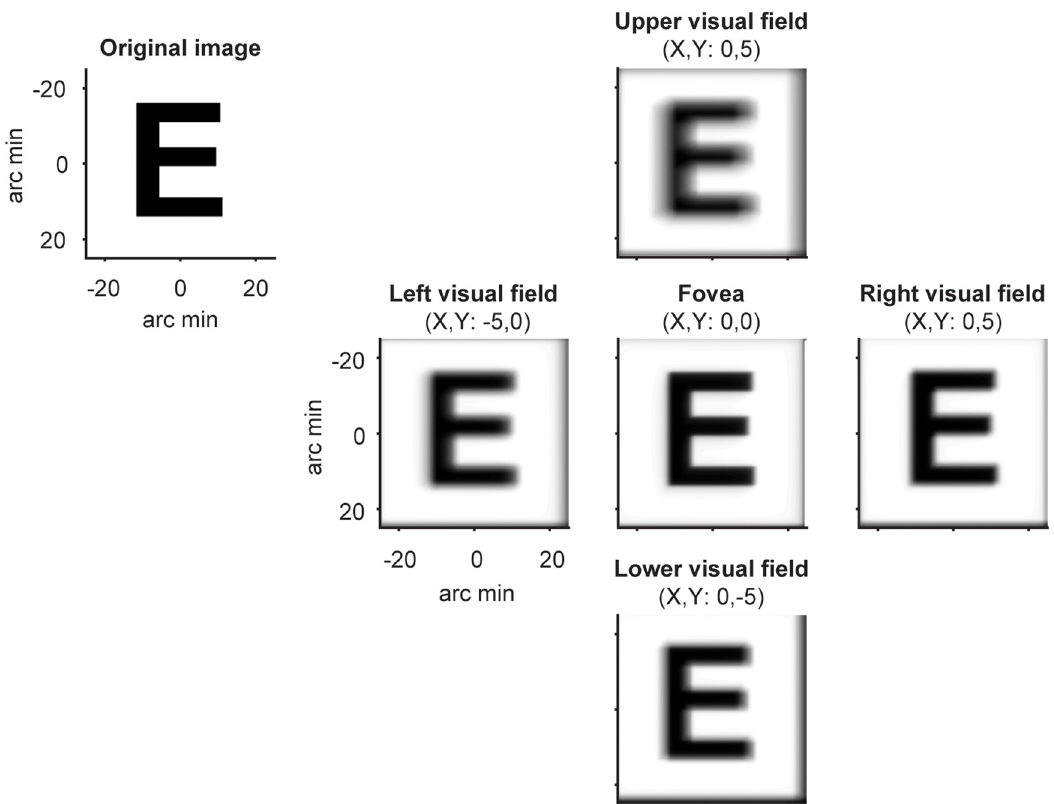
Fig 3. Variations in optical quality as a function of visual field location for example observer. The letter E was convolved with 5 location-specific point spread functions (PSFs) from an example observer, using wavefront measurements of image quality and correcting for the central refractive error. The wavefront measures are based on a prior study [43], and provided courtesy of Pablo